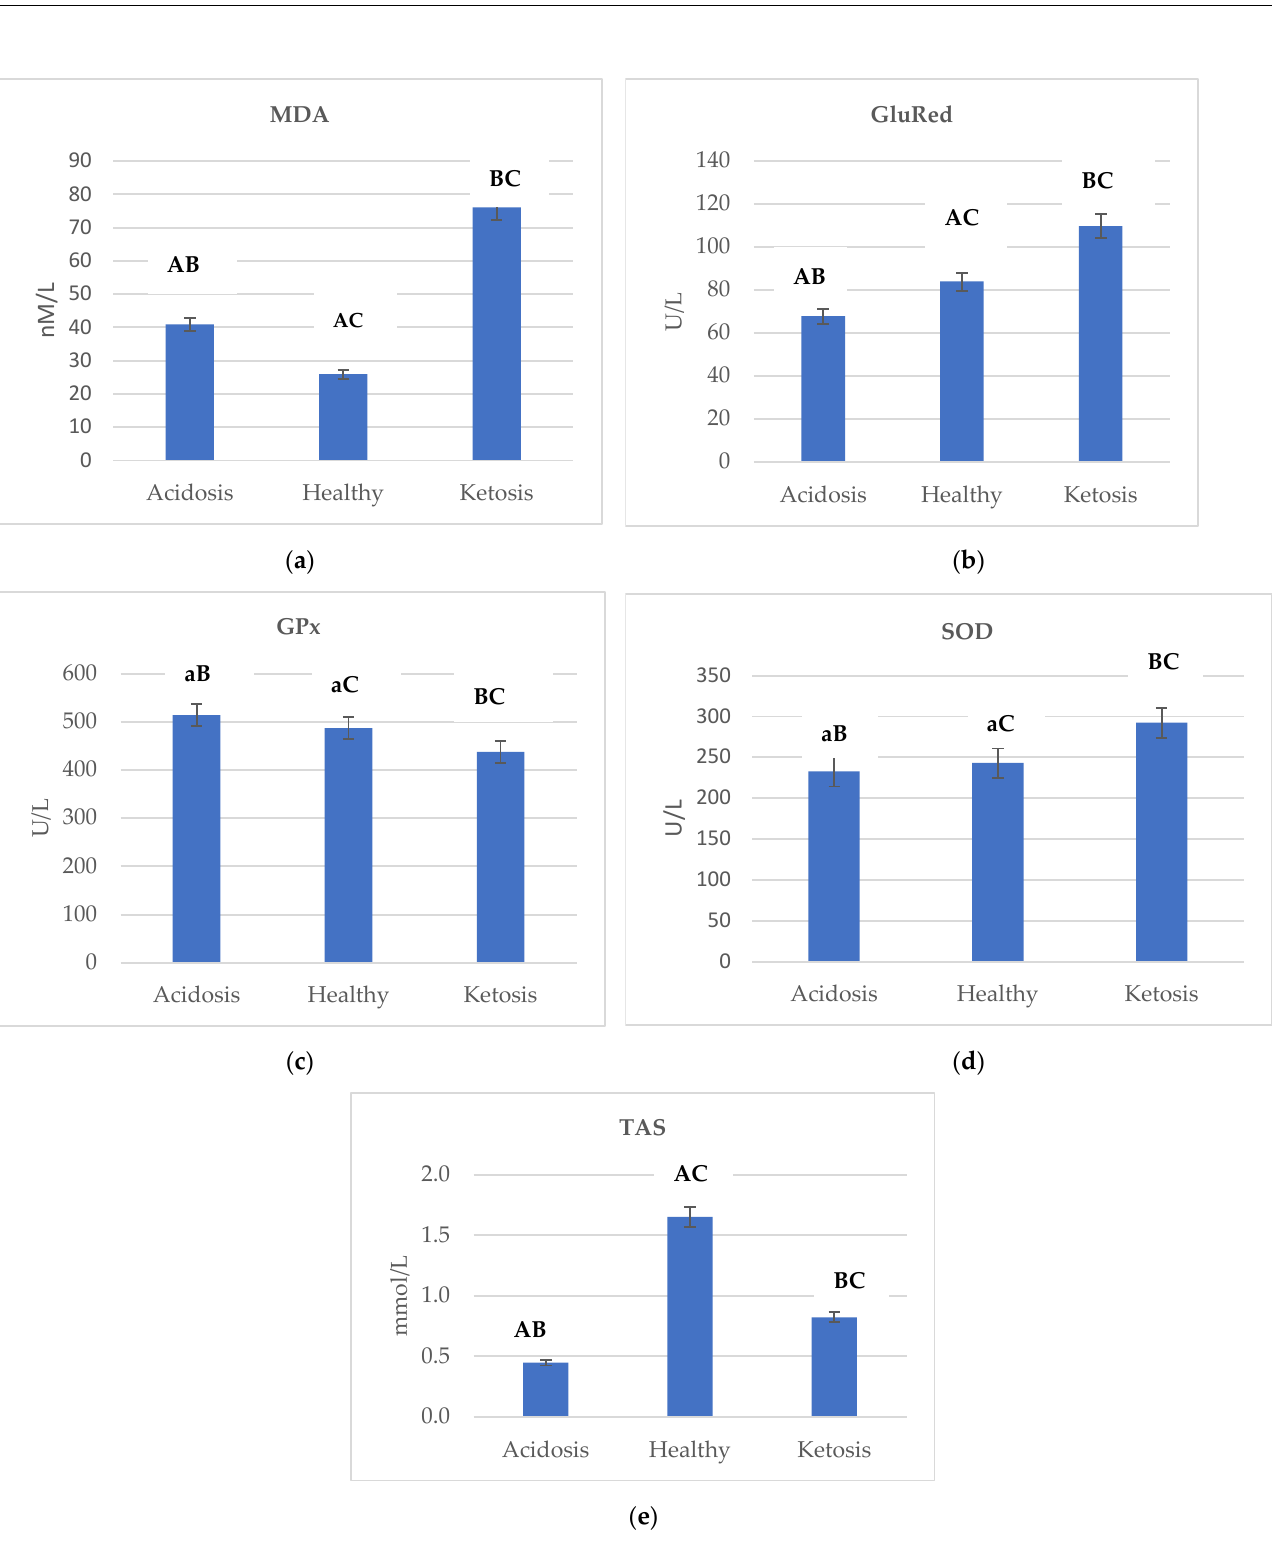
Figure 1. Differences in the activity of ( a ) MDA, ( b ) GluRed, ( c ) GPx, ( d ) SOD and ( e ) TAS depending on the health status of cows. Data were presented as least squares means with a standard error of the mean. Means marked with the same letters differ significantly at lowercase letters, p ≤ 0.05; uppercase letters, p ≤ 0.01. MDA, malondialdehyde; GluRed, glutathione reductase; GPx, glutathione peroxidase; SOD, superoxide dismutase; TAS, total antioxidant status; BHBA, β -hydroxybutyric acid.